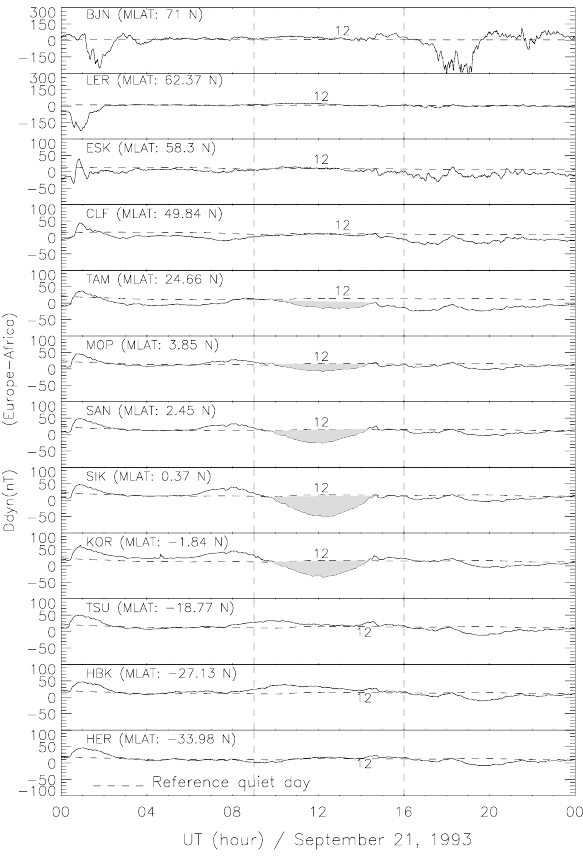
Fig. 6. Idem as Fig. 5, on 21 September